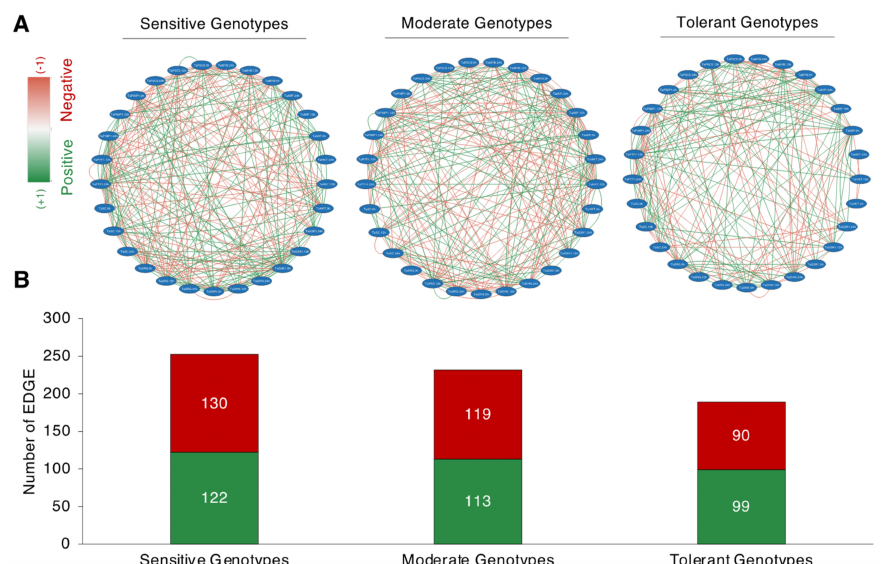
Figure 8. Correlation network analysis (CNA) of studied traits. ( A ) Correlation network analysis of analyzed traits of salt-sensitive (left panel), moderate (middle panel), and salt-tolerant (right panel) genotypes; ( B ) Positive and negative EDGE (total interaction) numbers of salt-sensitive, moderate, and salt-tolerant genotypes. Red ( − 1) and green (+1) colors correspond to the negative and positive edge associations, respectively ( p < 0.05). An edge encodes an interaction or a tie between two